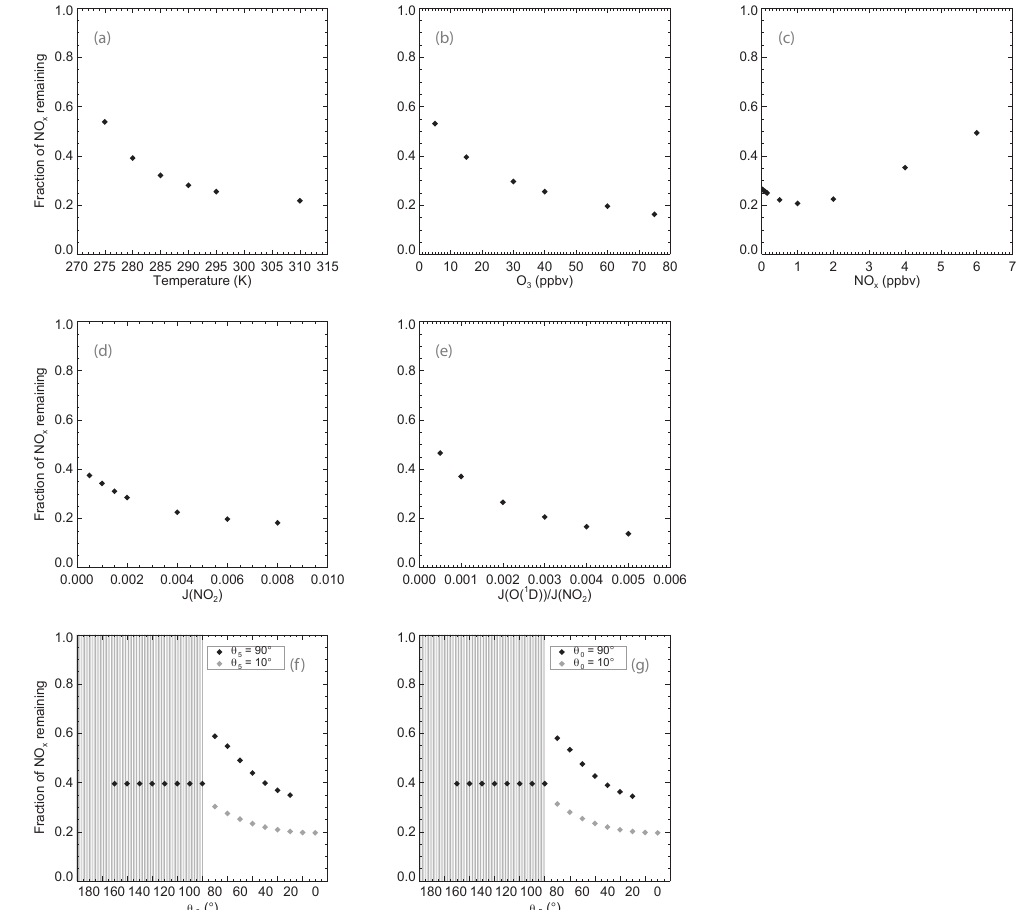
Fig. 2. PARANOX simulations of the fraction of NO x remaining after 5 hours for a plume released at 12:00h local time as a function of: (a) Temperature; (b) ambient O 3 concentration; (c) ambient NO x concentration; (d) J( NO 2 ) ; (e) J( NO 2 ) ; (f) θ 0 and (g) θ 5 . θ 0 and θ 5 are the J ( O ( 1 D )) solar zenith angle at initial release and 5h later. The simulation in panel (f) and (g) were not released at 12:00h, but for different initial and final solar zenith angles, corresponding to a variety of release hours at different latitudes. The shaded areas in panel (f) and (g) correspond to simulations during darkness. A NO x emissions strength of 20gs − 1 has been used. Ambient meteorological conditions are a neutral stability class, wind velocity is taken to be 8ms − 1 , temperature 295K and marine boundary layer height 400 m. Ambient concentrations for O 3 and NO x were set to 40ppbv and 100pptv,